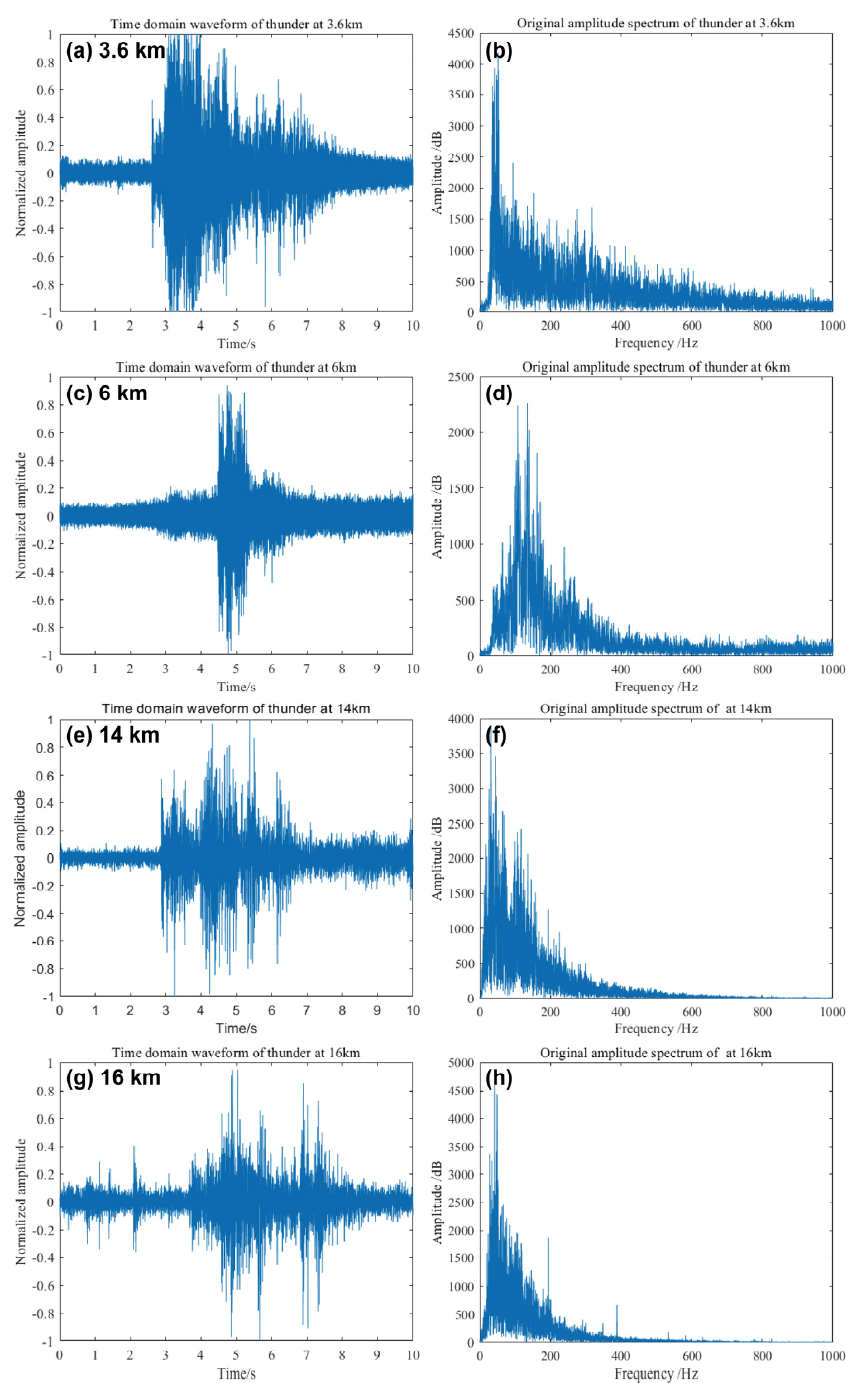
Figure 4. Original time-domain waveform (left panels) and spectrum (right panels) of the thunders generated by the lightning at ( a , b ) 3.6 km; ( c , d ) 6 km; ( e , f ) 14 km; and ( g , h ) 16 km away from the observational site.